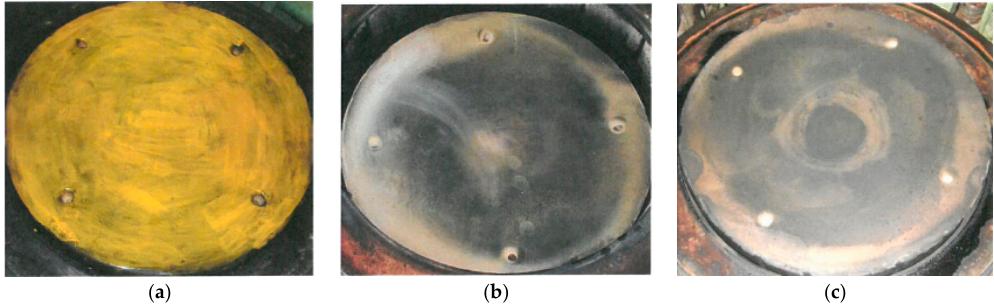
Figure 3. View of thermal paint on the top of the piston crowns; ( a ) before temperature estimation trial; ( b ) after trial with high wear rate; ( c ) after trial with normal wear rate. Table 2. Specifications of the selected Sulzer engine.